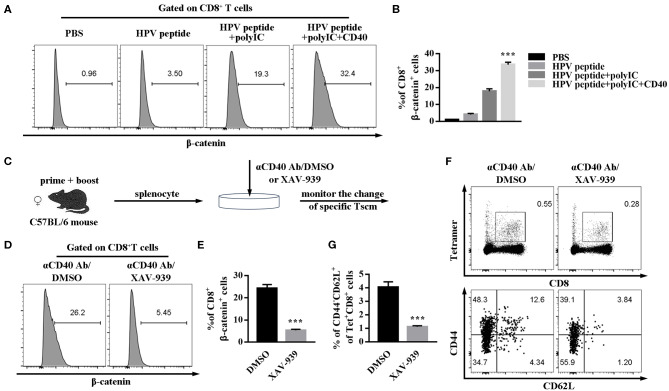
CD40 regulates Wnt/β-catenin signaling to elicit a high level of HPV16-specific CD8 Tscm cells. (A,B) Flow analysis of β-catenin in CD8+ T cells from C57BL/6 mice immunized by different vaccination strategies. (C) Splenocytes from immunized mice were treated with aCD40mAb plus DMSO or aCD40mAb plus XAV-939 for 48 h, then the percentage of β-catenin in CD8+ T cells was measured (D,E) and HPV16 E7 specific CD8+ Tscm cells (F,G) was detected by FCS analysis. Error bars represent the mean ± SD of three independent experiments. ***p < 0.001.